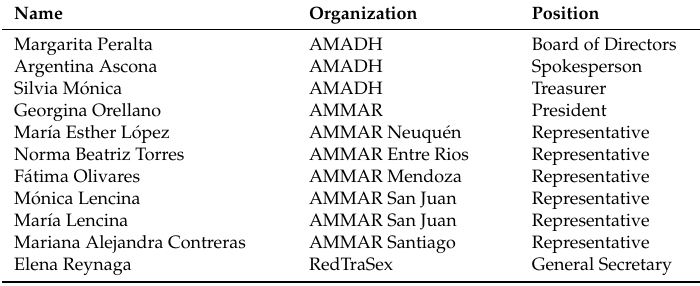
Table A2. Interviews with sex worker/prostituted women’s organizations in Buenos Aires,